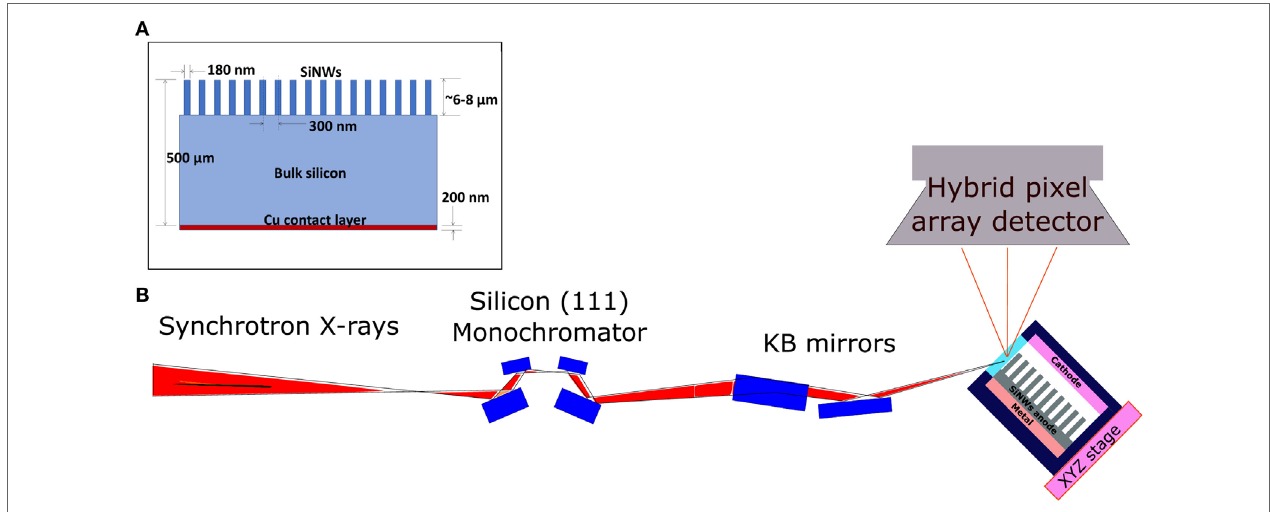
FigUre 1 | (a) A schematic illustration of the single-crystalline silicon nanowires (SiNWs) sample. (B) A schematic illustration of the synchrotron X-ray microdiffraction experimental setup (Kunz et al., 2009; Tippabhotla et al.,